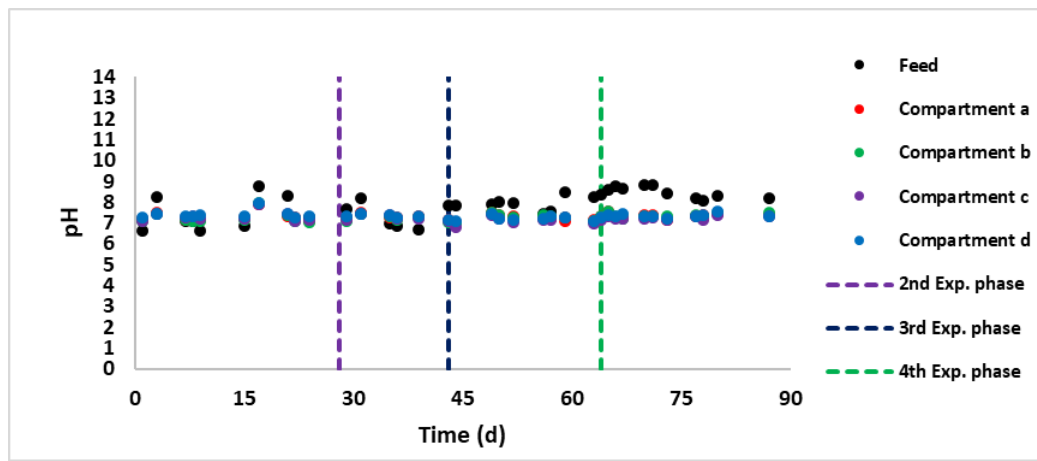
Appl. Sci. 2022 , 12 , 13037 Figure 15 . Daily pH values of the feedstock and the reactor compartments. Figure 15. Daily pH values of the feedstock and the reactor compartments.